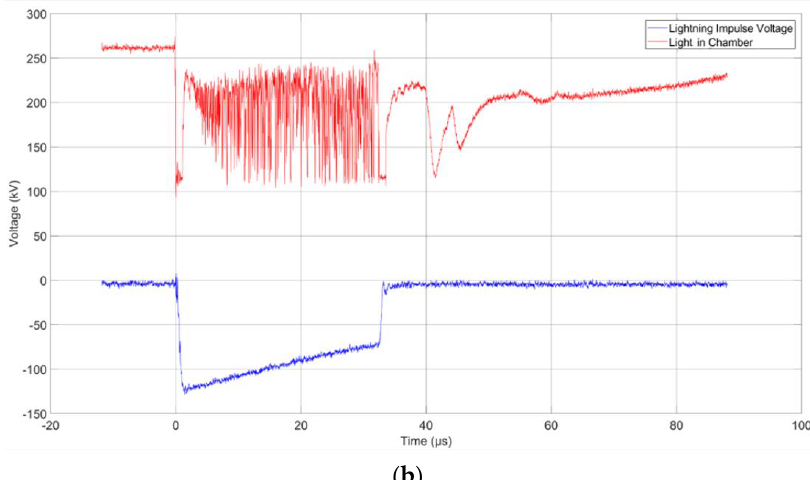
Figure 16. Examples of voltage and light waveforms collected during LI tests in synthetic ester: ( a ) without breakdown, ( b ) when breakdown occurs.